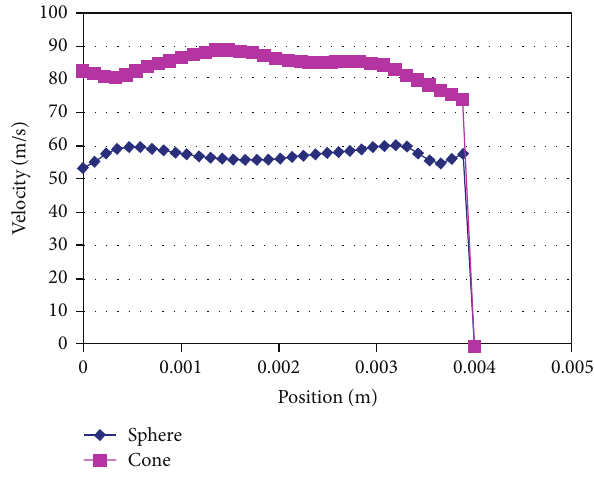
Figure 4: Urinary flow rate values obtained from